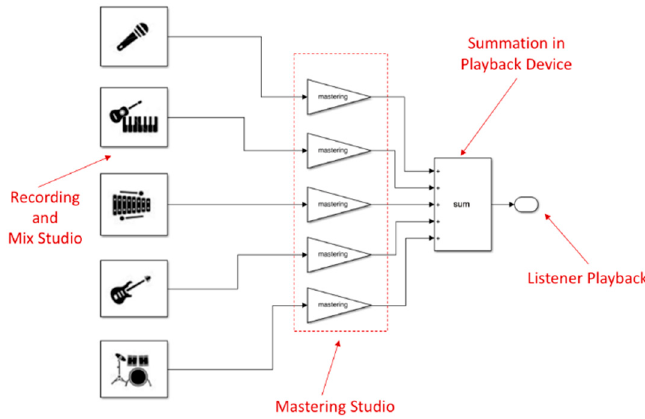
Figure 12. Mastering approach for variPlay.